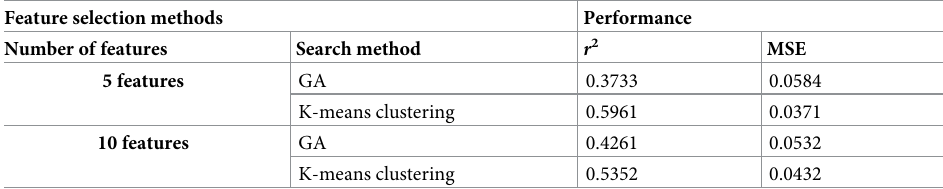
Table 11. Average performances for SVR models built by Wrapper